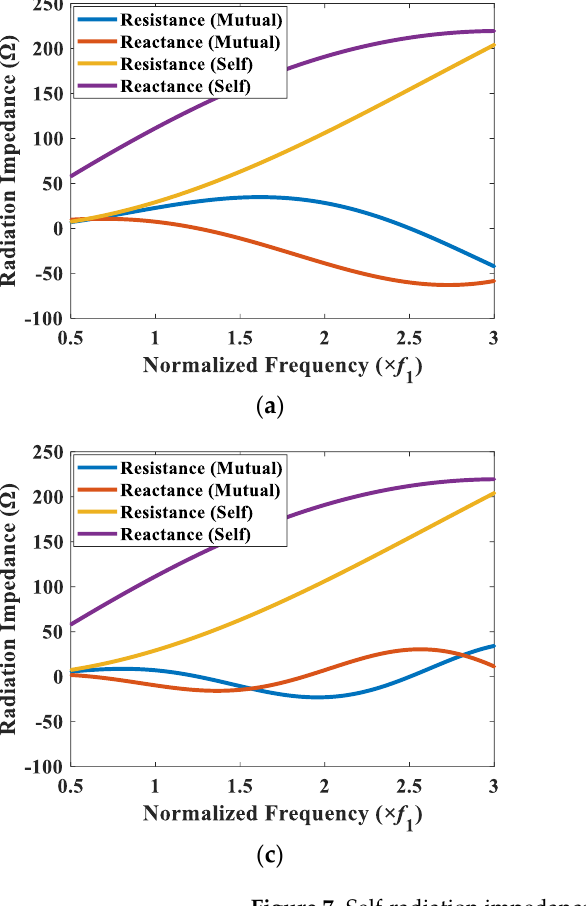
Figure 7. Self-radiation impedance of cymbal 1, and mutual radiation impedance between cymbals 1 and 2 for different CTC spacings: ( a ) 0.2 𝜆 ; ( b ) 0.3 𝜆 ; ( c ) 0.4 𝜆 ; ( d ) 0.5 𝜆 .